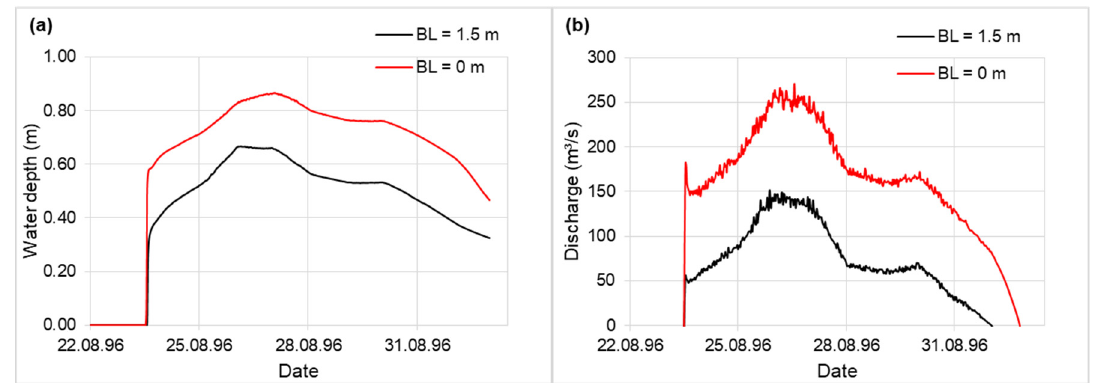
Figure 11. For the indicated final breach levels (BL) (BL = 0 m (levee erodes to the ground level) and BL = 1.5 m (levee erodes to half its height, which is 3 m)) and the historical levee breach location of the August 1996 levee breach flood event at Wonji: ( a ) modelled water depth at an office location; ( b ) modelled breach discharge. The office location and the historical breach location are shown in Figure 3.